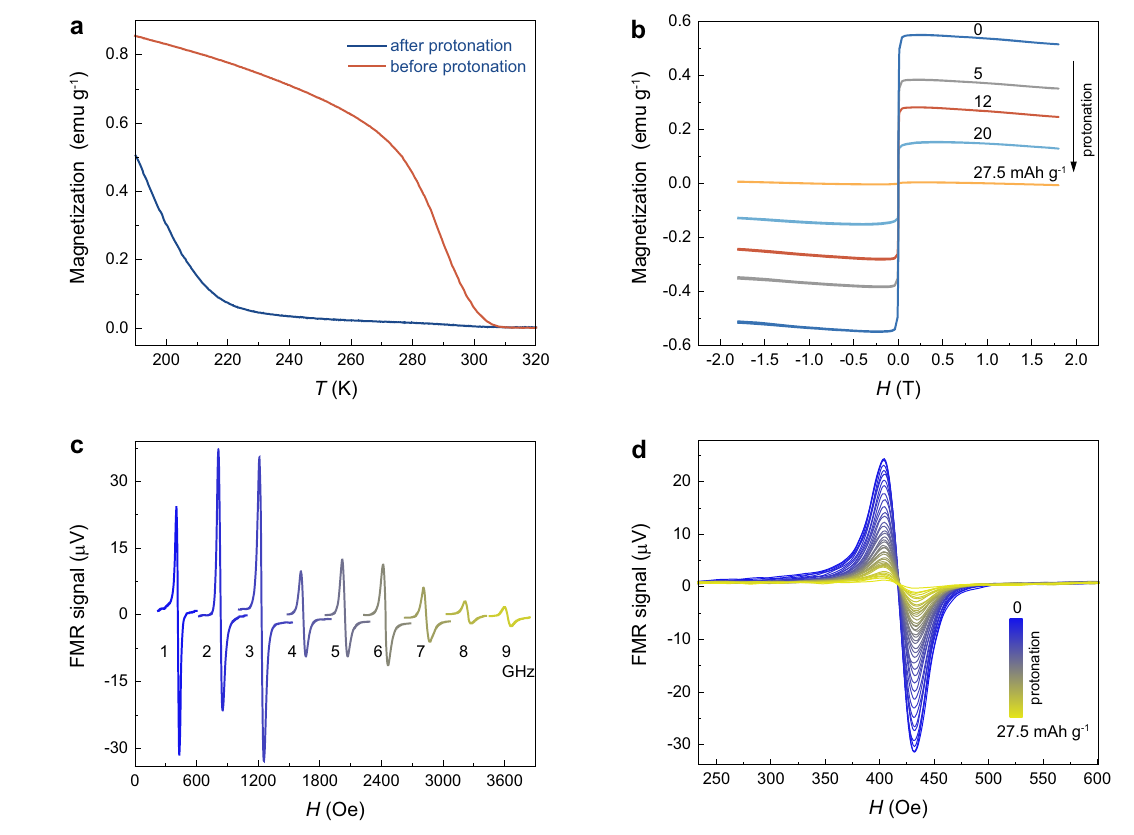
Fig.3|ProtoncontrolofmagnetismforVCr-PBA.a Temperaturedependenceof magnetization of VCr-PBA before and after protonation. b Magnetic hysteresis loops measured at room temperature for VCr-PBA at various protonation levels.